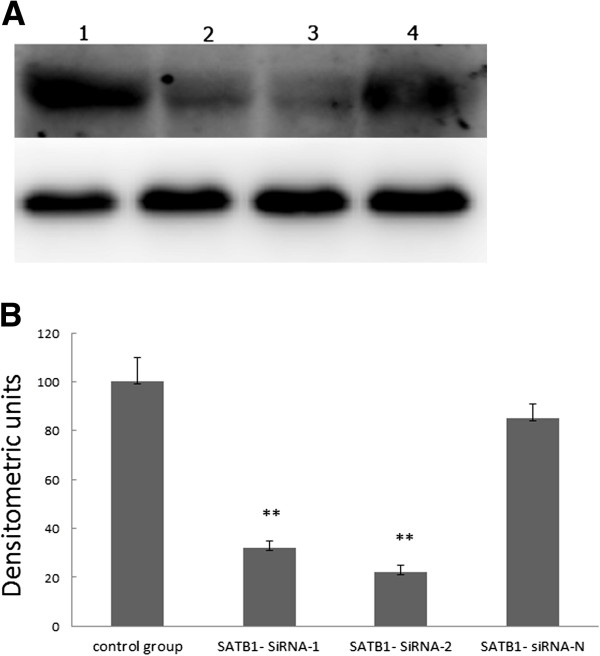
SATB1-siRNA inhibited SATB1 expression in NCI-H446 cells. A, Western blot of SATB1 in four groups: 1, control group; 2, transfected with SATB1- SiRNA-1; 3, transfected with SATB1- SiRNA-2; 4, transfected with SATB1- siRNA-N; B. Densitometric analysis of SATB1 protein levels.